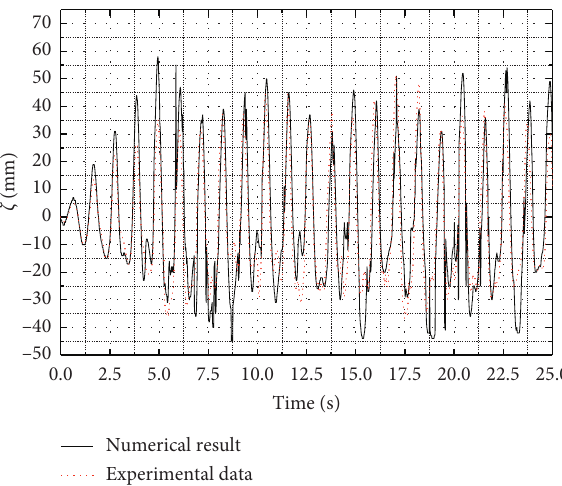
Figure 10: Comparison of time history of interfacial wave between experimental data and numerical results when the total liquid depth is 10cm.